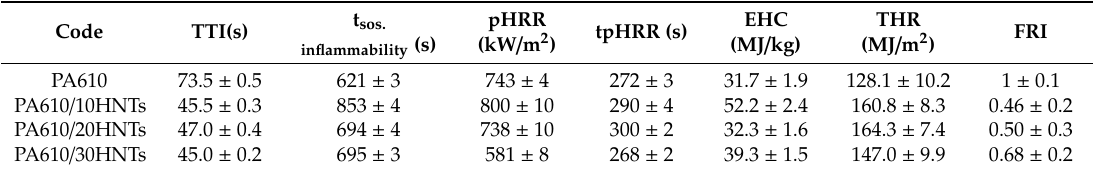
Table 2. Summary of thermal parameters obtained with the calorimetric cone test (CCT) on the PA610 and HNTs samples.